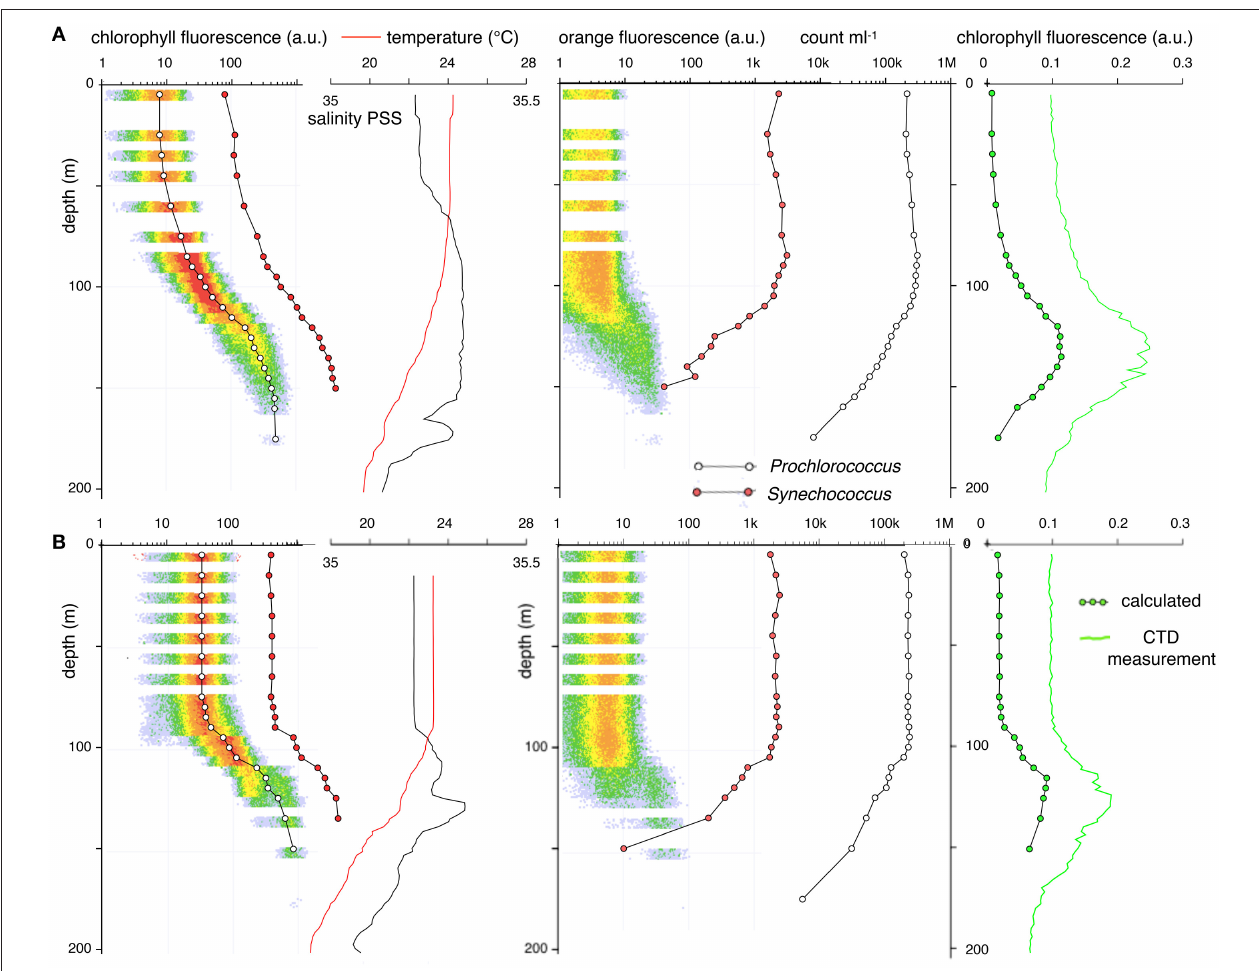
FIGURE 6 | Abundance and optical properties of Prochlorococcus (open circles) and Synechococcus (red circles) measured by flow cytometry at Station ALOHA. The solid red line indicates temperature; the black line indicates salinity. The open circles represent the mean fluorescence and abundance of Prochlorococcus . Solid red circles represent those values for Synechococcus . The green line represents bulk fluorescence as measured by the CTD. The solid green circles represent the product of the mean Prochlorococcus fluorescence and the cell counts. (A) Depth profile in calm weather (March 14, 2014, 20:45 HST). (B) Depth profile after a deep mixing event (March 16, 2014, 18:10 HST). Before the mixing event, the mean fluorescence of Prochlorococcus and Synechococcus increases monotonically over a 50-fold range with depth. Within 24h after homogenization of the upper water column, as evidenced by the straight salinity and temperature measurements, the fluorescence of Prochlorococcus and Synechococcus are invariant with depth at a value intermediate to the surface and deep measurements obtained just before the storm. During these changes, there is no appreciable change in Prochlorococcus or Synechococcus